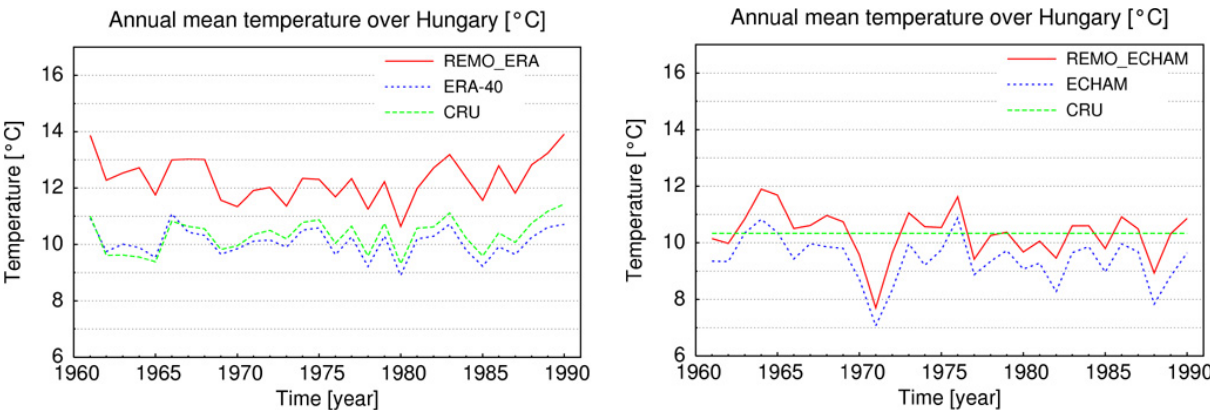
Figure 1. Evolution of the annual mean 2-m temperature [ ◦ C] in the REMO simulations (red curves: ERA40-driven REMO on the left, ECHAM-driven REMO on the right), the corresponding global fields (blue curves: ERA40 on the left, ECHAM5 / MPI-OM on the right) and the CRU1.2 observation (green curve on the left) and its 30-year mean (green line on the right) over Hungary for 1961–1990. Table 1. Mean temperature di ff erences [ ◦ C] between the REMO simulations and the corresponding driving fields (ERA40-driven REMO and ERA40, ECHAM-driven REMO and ECHAM5 / MPI-OM), the two regional simulations (REMO ERA and REMO ECHAM) and the two global fields (ERA40 and ECHAM5 / MPI-OM) at 2m and 850hPa over Hungary for 1961–1990. REMO ERA REMO ECHAM REMO ERA ERA–ECHAM – ERA – ECHAM – REMO